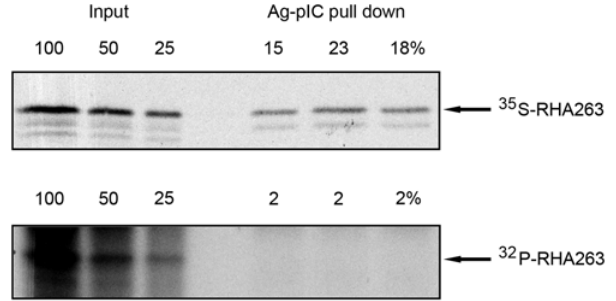
Figure 4. PKR phosphorylation perturbs the association of RHA with RNA. A phosphor image of the recovery of total 35 S-labeled RHA peptide encoding amino acid residues 1 to 263 (top panel) compared to 32 P-labeled peptide phosphorylated by PKR in vitro (bottom panel) pulled down with pIC bound to agarose beads (Ag-pIC) and electrophoretically separated. The recovery of three replicated radioac- tively labeled peptides was quantitated as a percentage of the input extract